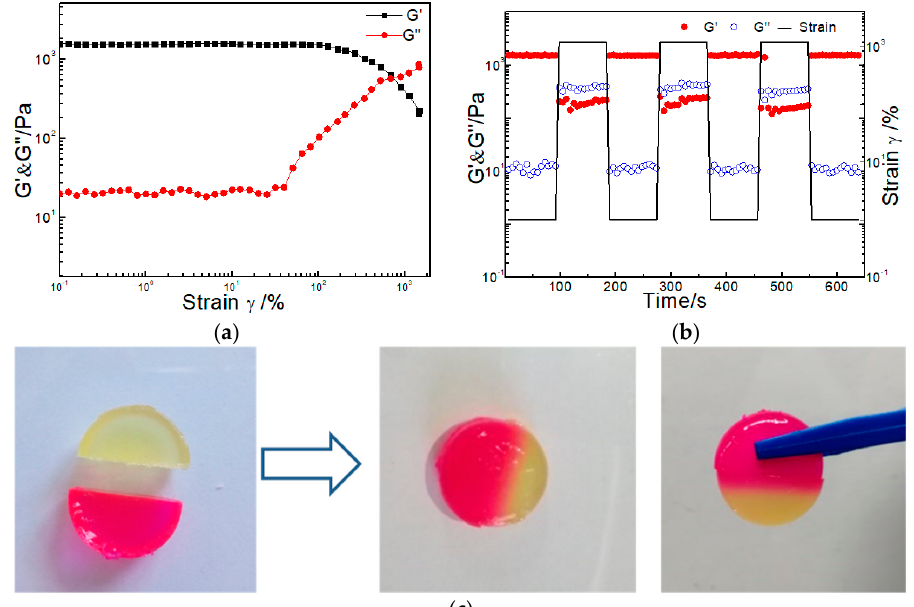
Figure 4. ( a ) Strain sweep measurements of hydrogel Gel 20 -3; ( b ) Repeated dynamic strain step tests (1% or 1200%); ( c ) Images of the self-healing process of two individual gel fragments.